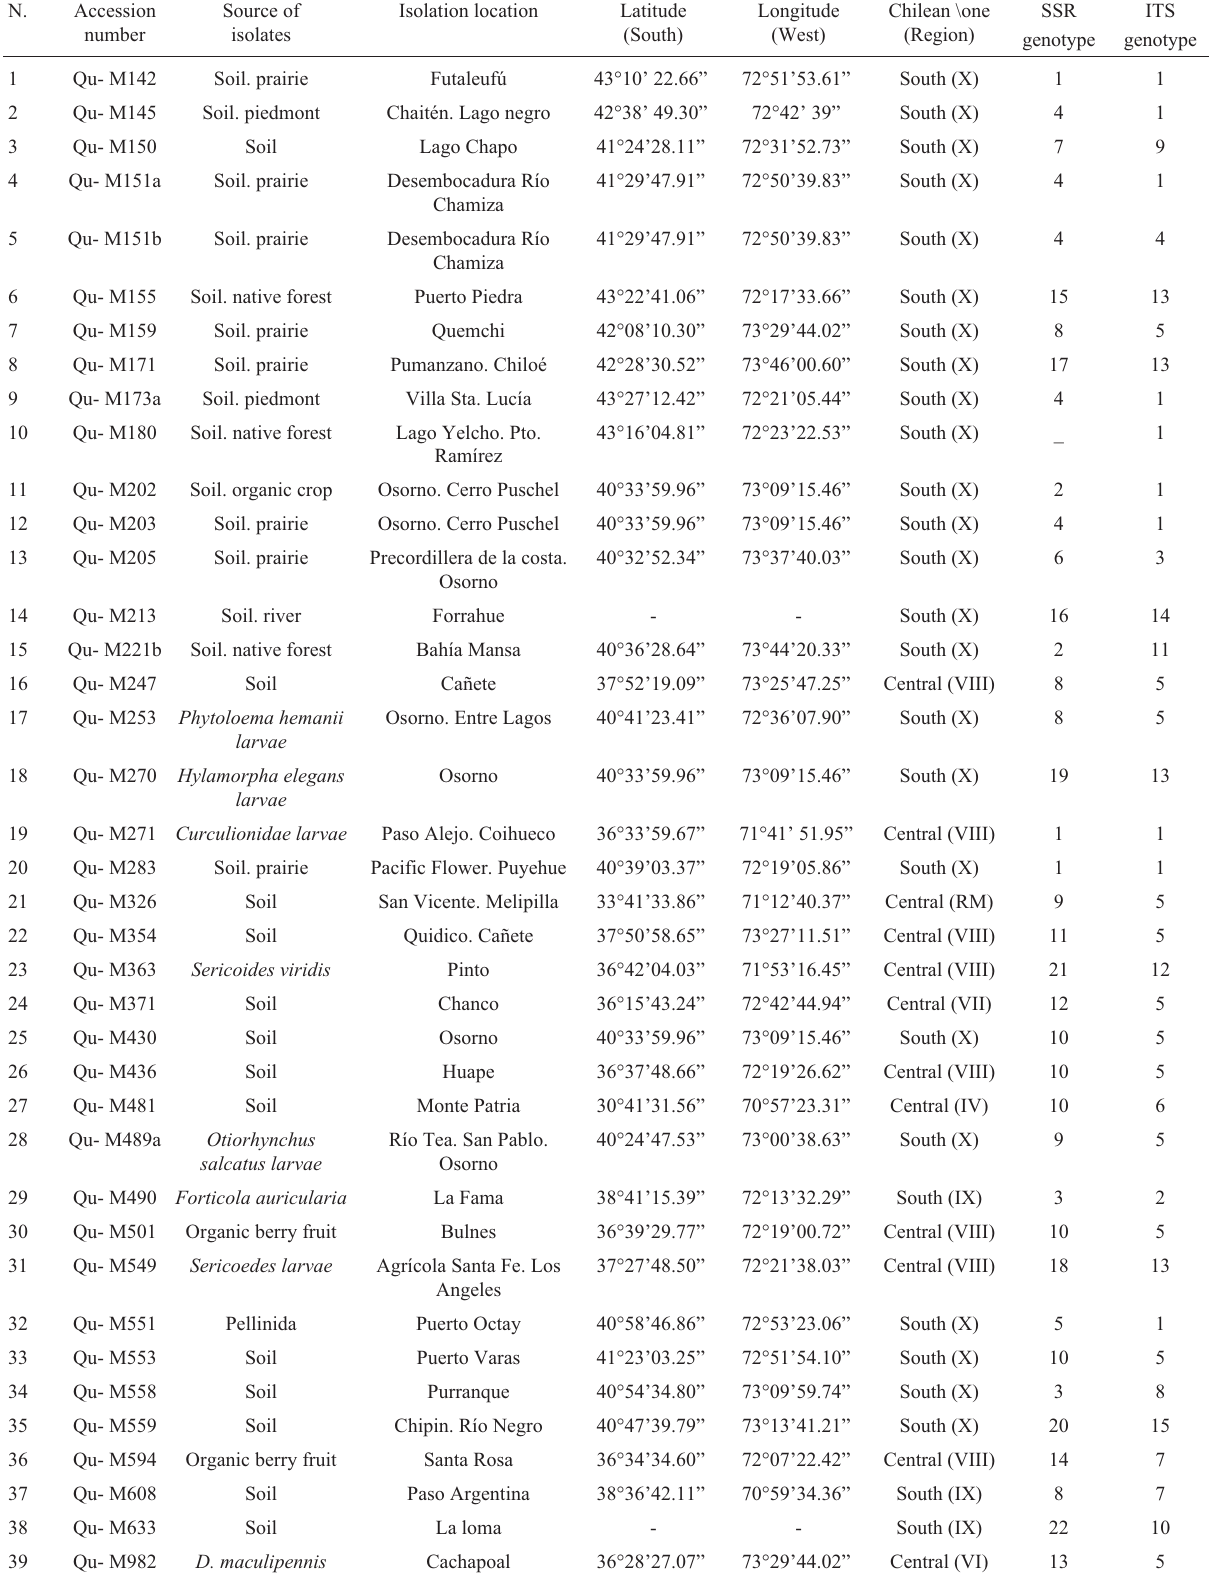
Table 1 - The source of the 39 Chilean Metarhizium anisopliae var. anisopliae isolates investigated and their random amplified polymorphic DNA (RAPD), simple sequence repeat (SSR) and internal transcribed spacer (ITS) genotypes.